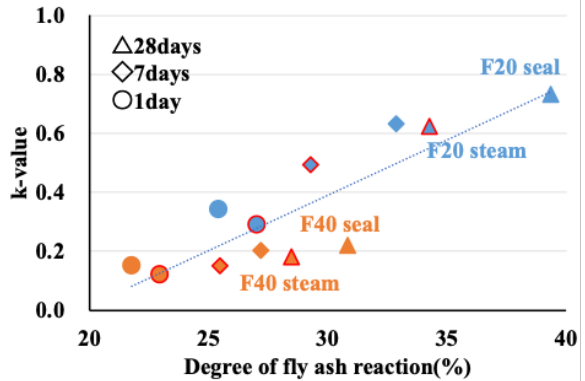
Figure 6. Degree of fly ash reaction with age.